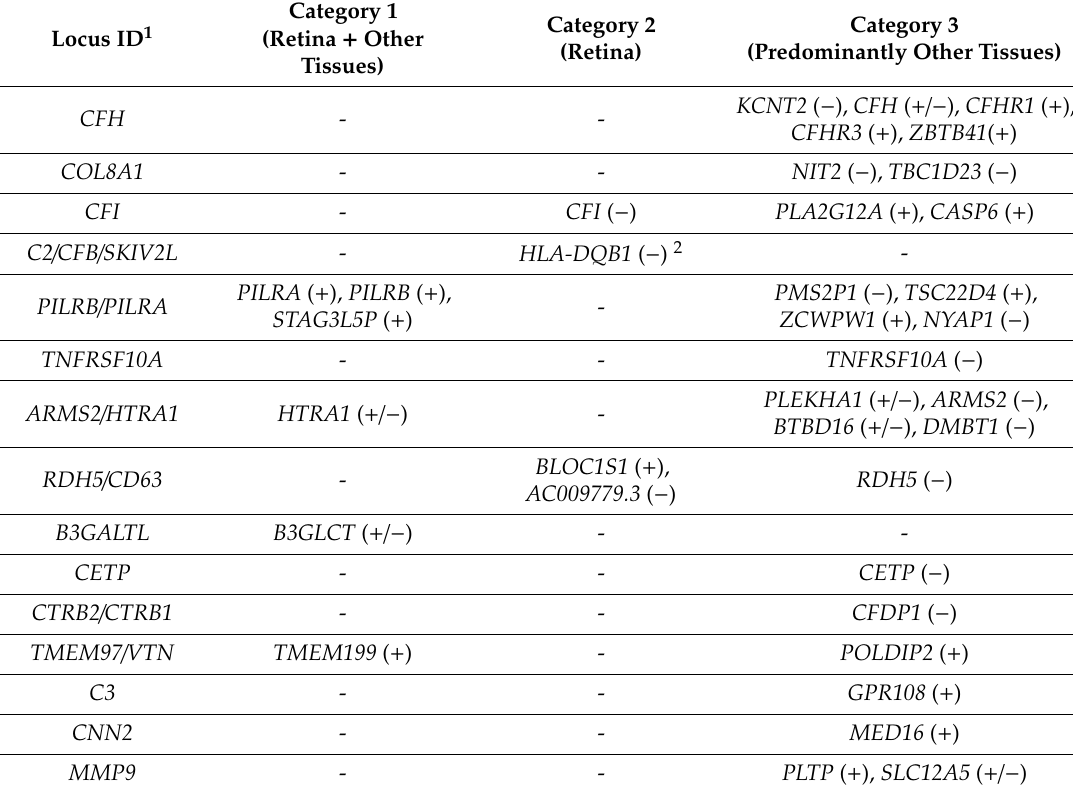
Table 2. Known AMD-associated loci [8] harboring gene expression regulatory e ff